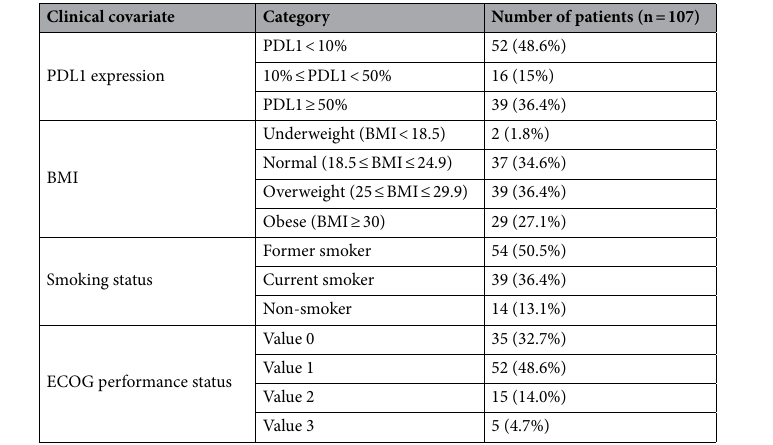
Table 2. Clinical covariate categories and number of